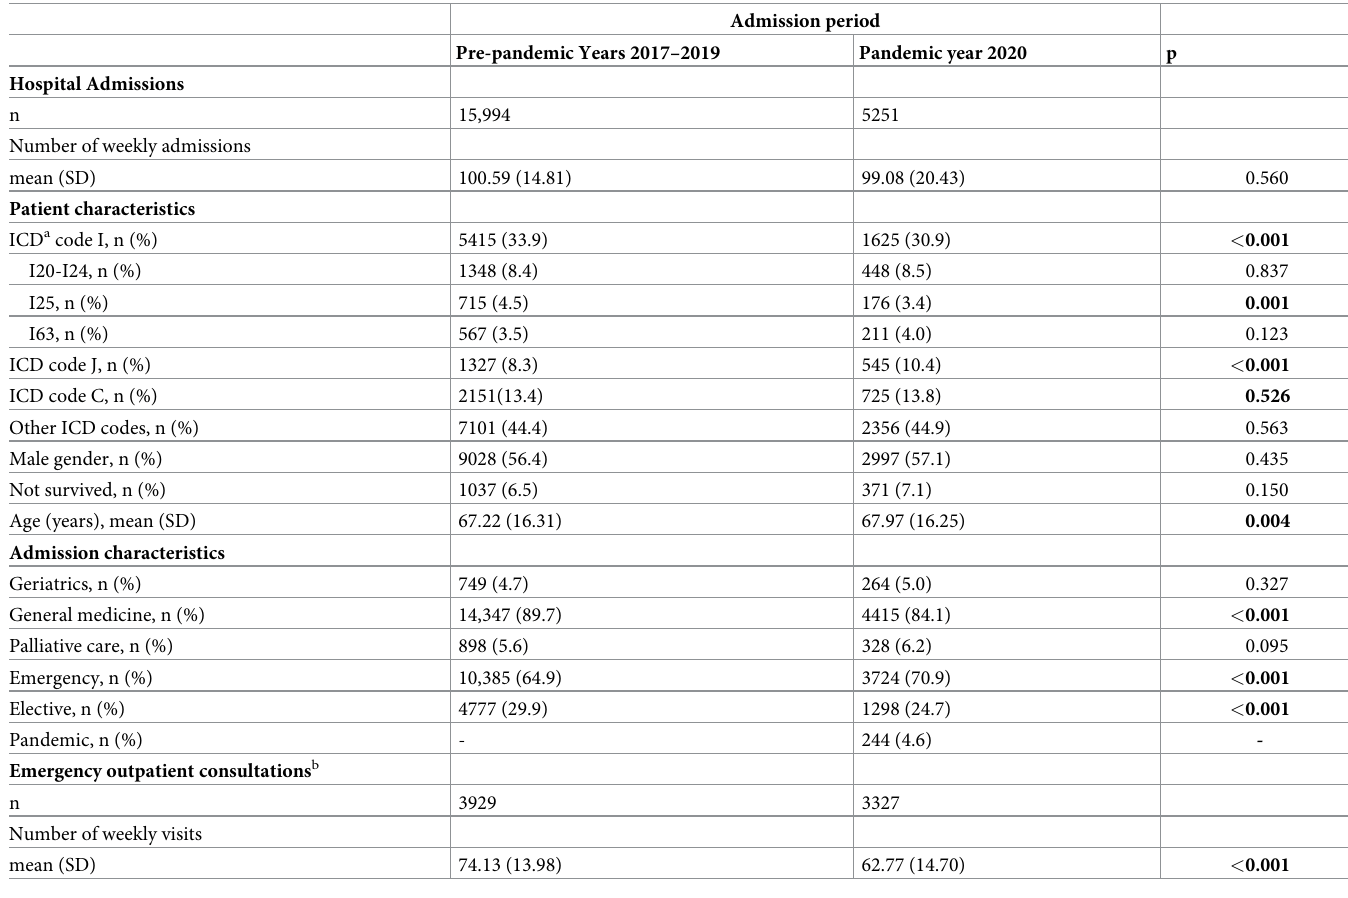
Table 1 represented a descriptive analysis of the weekly admissions by period: pre-pandemic (years 2017–2019) and pandemic (year 2020). Overall, no significant difference was found in the average weekly number of admissions between pandemic and pre-pandemic period, 99.08 (20.43) versus 100.59 (14.81), p = 0.560. Table 1. Admissions and emergency outpatient consultations by period, type of admissions and patient characteristics. P are the p-values of Chi-Square test (categor- ical/binary variables) and t-test for mean values (continuous variables). Significant values, p � 0.05, were denoted in